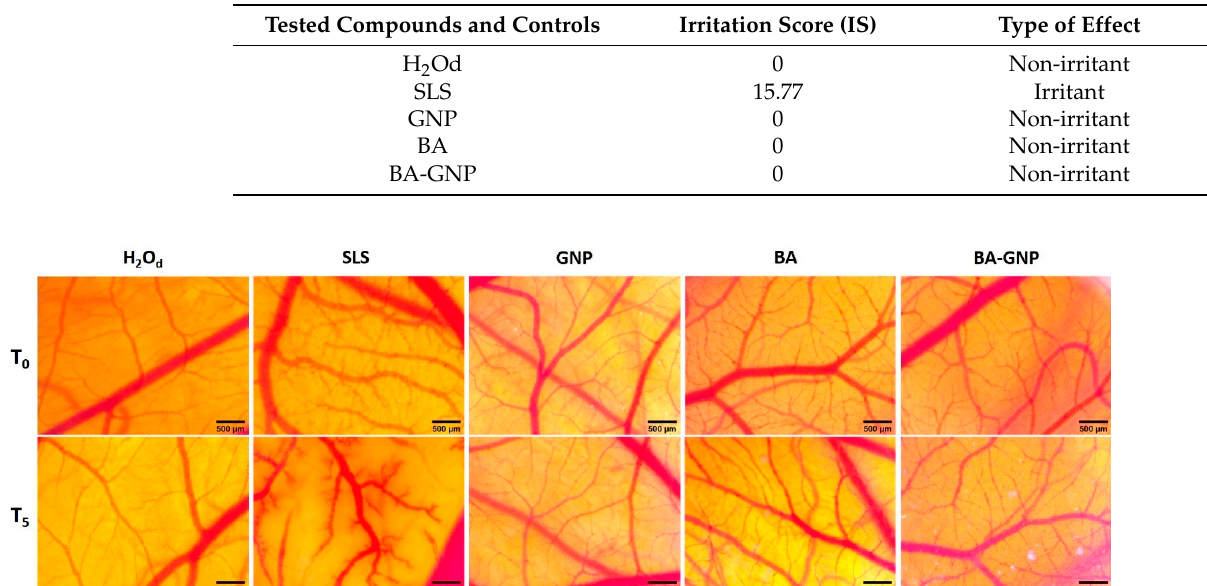
Table 3. The comparative assessed irritant potential of BA, GNP and BA-GNP.